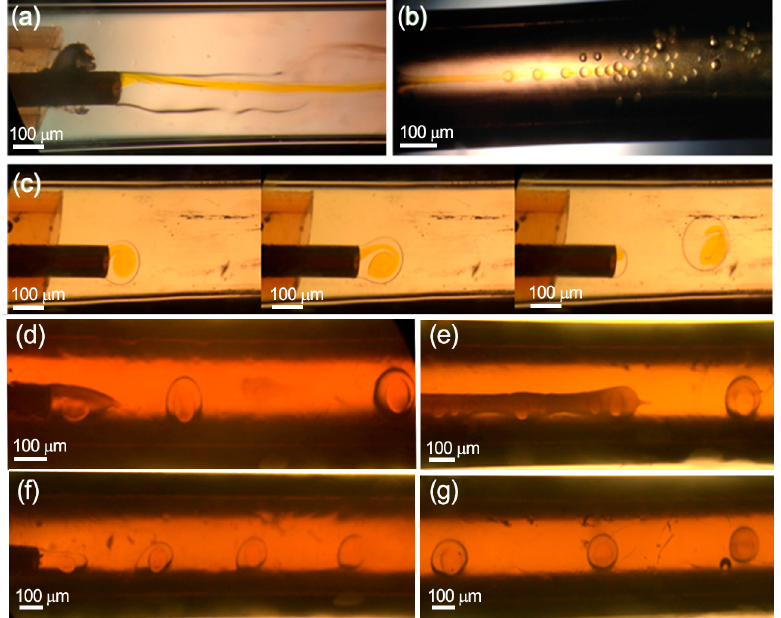
Figure 2. Optical microscopy images of the double drop of emulsion formed at the end of the coaxial capillaries according to the composition of the phases. Without surfactants in the continuous and dispersed phases, 2% Eudragit ® : ( a ) viscosity of the continuous phase < 500 cSt; ( b ) viscosity of the continuous phase = 500 cSt. Addition of surfactants in the continuous and dispersed phases: ( c ) viscosity 500 cSt, 2% Eudragit ® ; ( d ) viscosity 1000 cSt, 2% Eudragit ® ; ( e ) viscosity 1000 cSt, 4% Eudragit ® ; ( f ) viscosity 2000 cSt, 2% Eudragit ® ; ( g ) viscosity 2000 cSt, 4% Eudragit ®